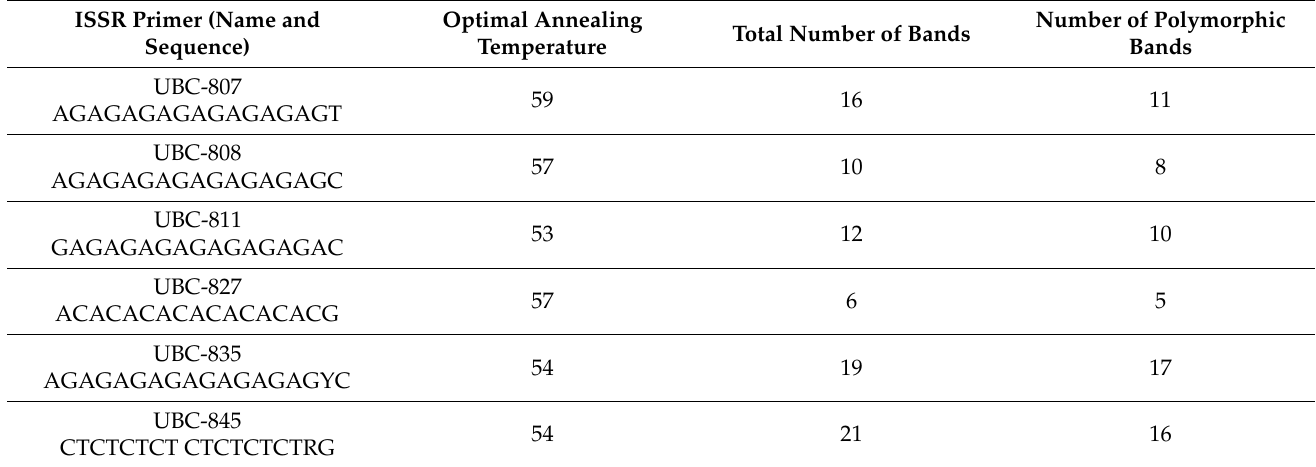
Table 4. ISSR primers studied for the study of genetic diversity of Primula veris